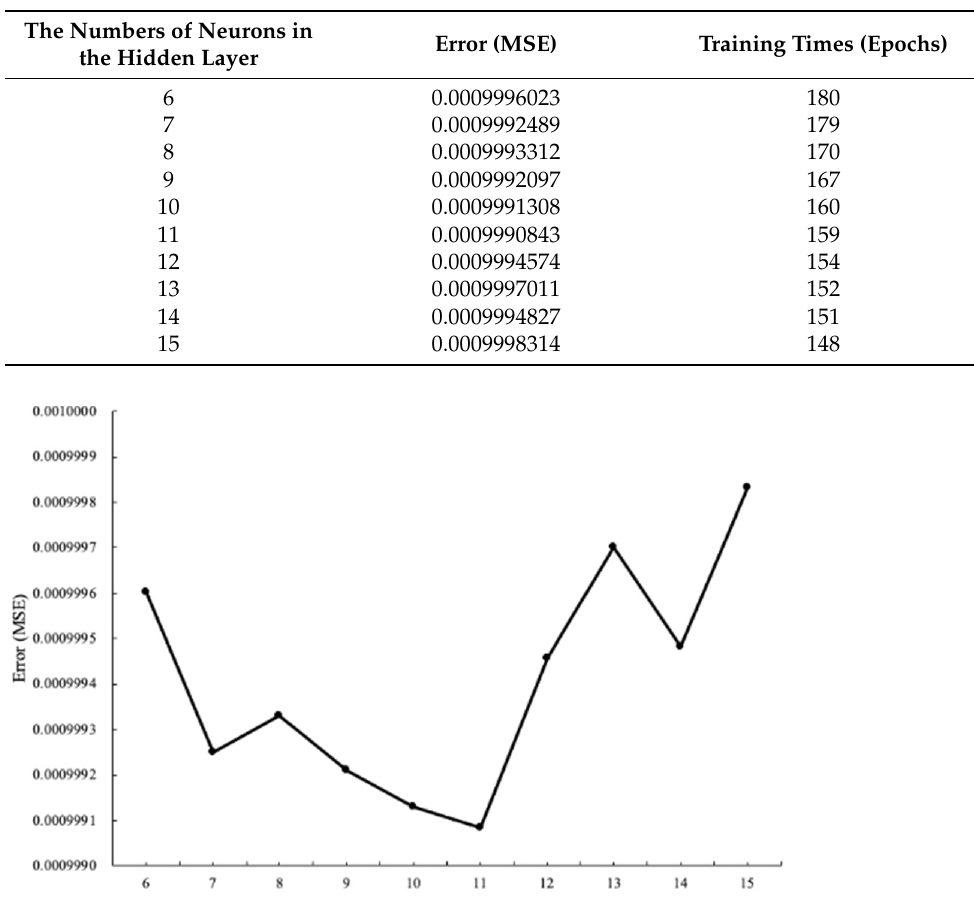
Figure 4. Convergence process of improved Elman neural network.